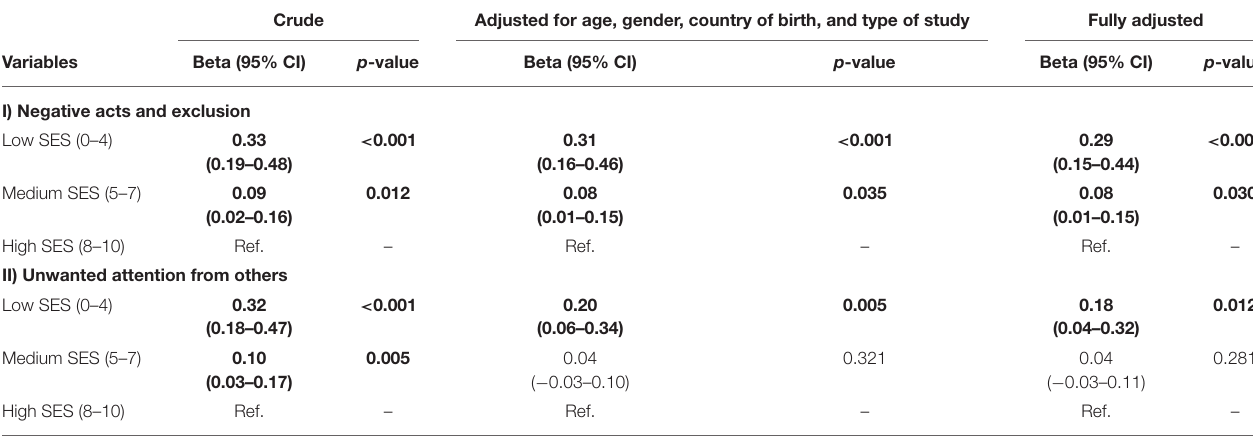
TABLE 4 | Association between subjective socioeconomic status and mean level of negative experiences on social media, I) negative acts and exclusion and II) unwanted attention from others. Crude Adjusted for age, gender, country of birth, and type of